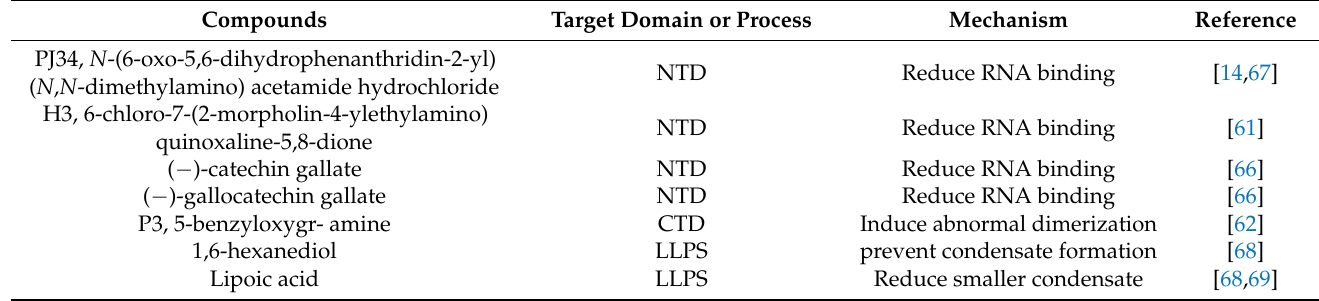
Table 1. β -CoV inhibitors target N